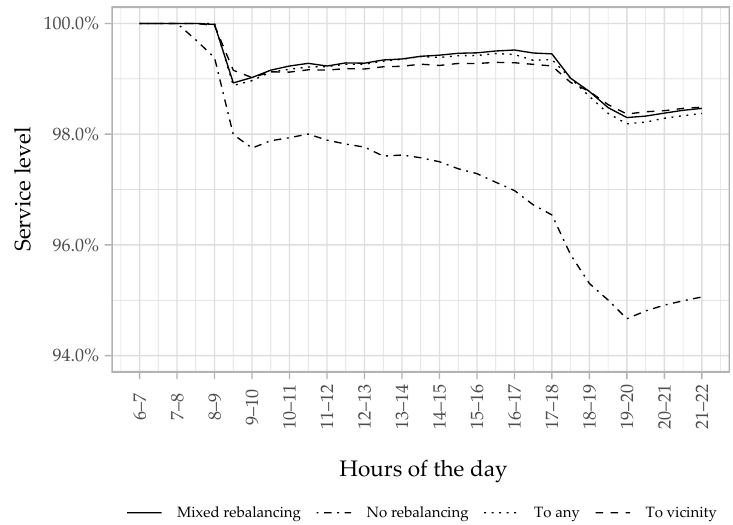
Figure 7. Variation of the service level during the day for 110 bikes.